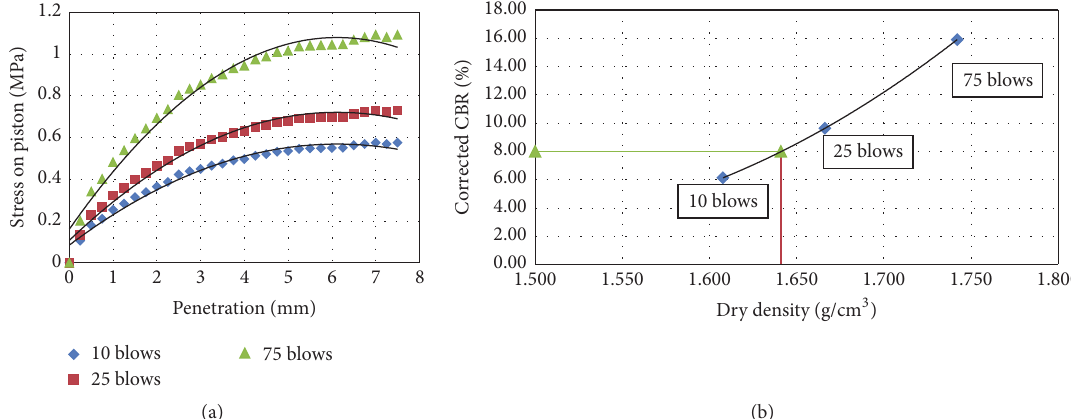
Figure 8: (a) Relationship between resistance and penetration for soil with 5% FSSA additives. (b) CBR value for soil with 5% FSSA additives.